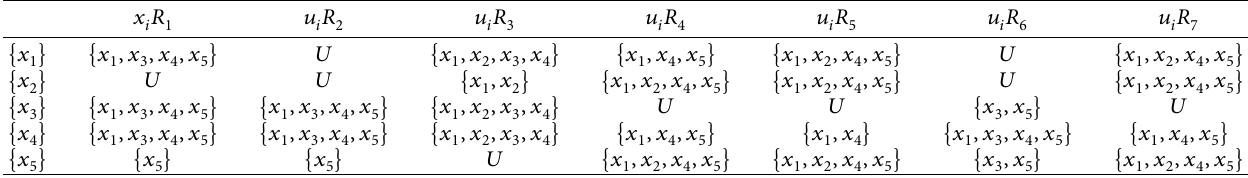
Table 4: Right neighborhood of the seven